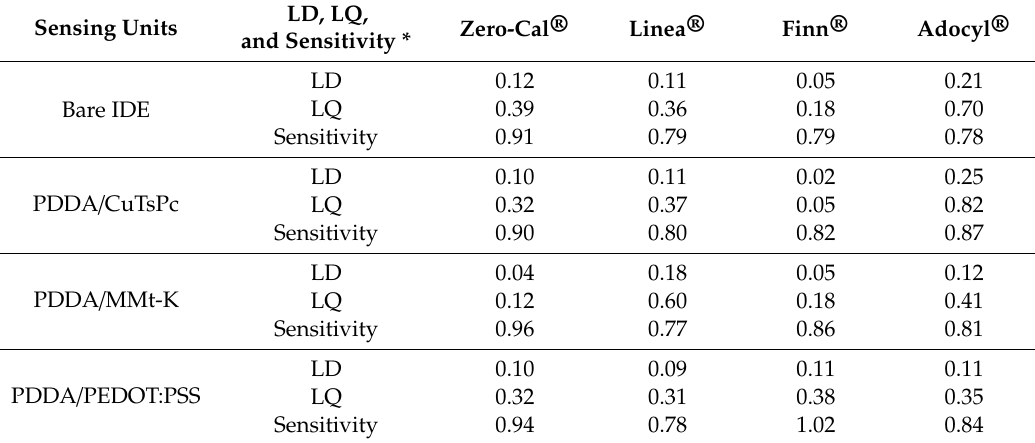
Table 1. Limit of detection (LD), limit of quantification (LQ), and sensitivity for the sucralose-based sweeteners using bare IDE, PDDA / CuTsPc, PDDA / MMt-K, and PDDA / PEDOT:PSS as sensing units in the microfluidic e-tongue